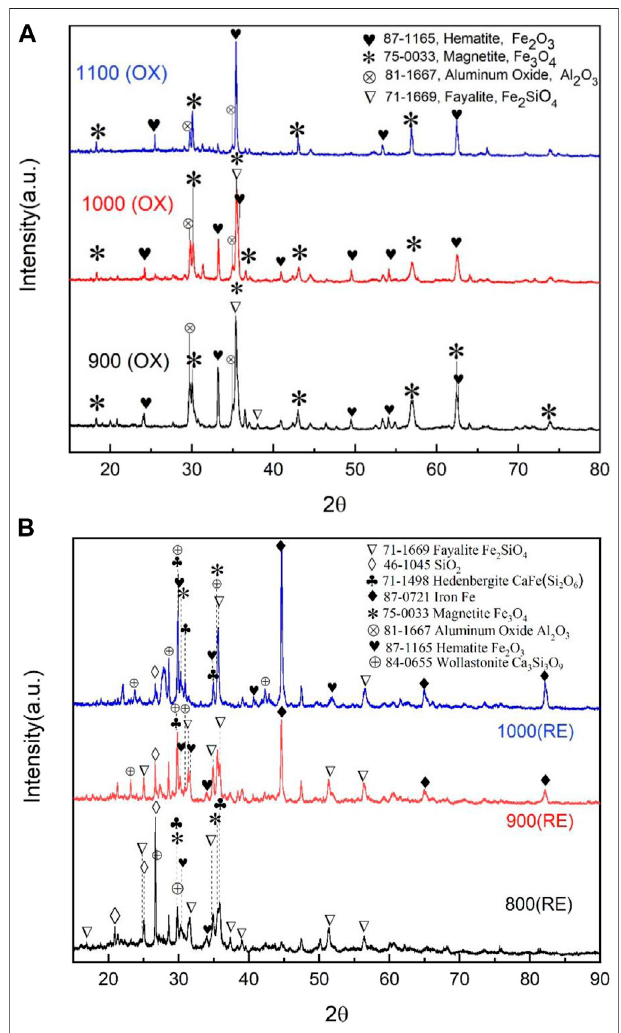
FIGURE2| XRDpatterns ofoxidized and reducedcopper slag. (A) XRD pattern of oxidized copper slag. (B) XRD pattern of reduced copper slag.